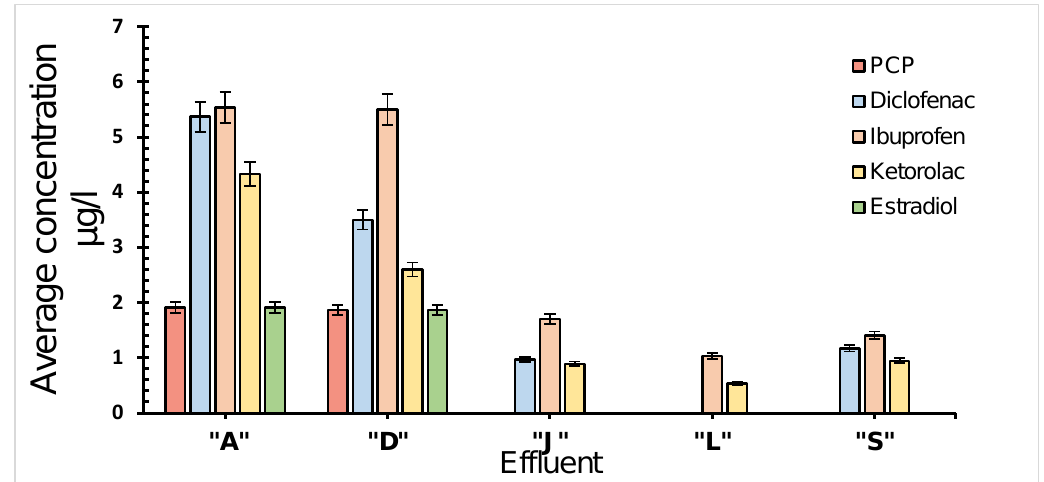
Figure 8. Concentration of Emerging Contaminants found in study sites.